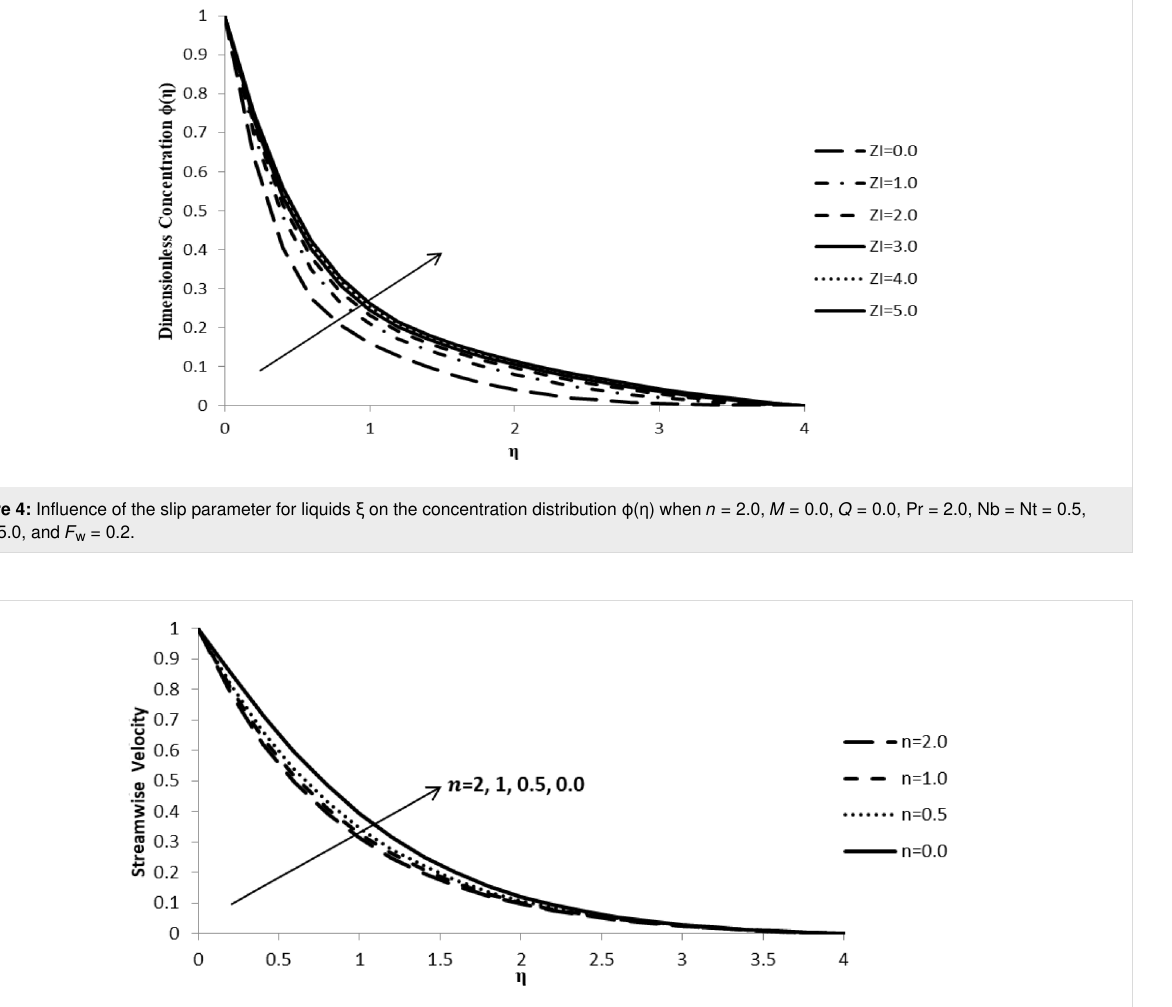
Figure 5: Influence of the stretching parameter n on the streamwise velocity component f ´( η ) when ξ = M = Q = 0.0, Pr = 2.0, Nb = Nt = 0.5, Le = 5.0, and F w =